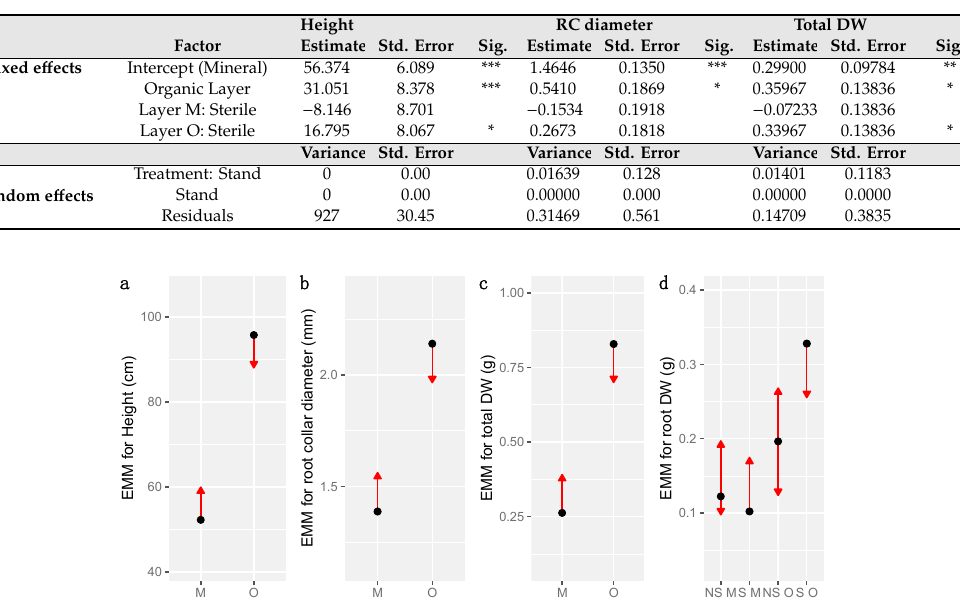
Figure 4. Comparison of estimated marginal means (EMM) showing significant differences of height ( a ), root collar diameter ( b ), total dry weight ( c , DW), and root DW ( d ) of seedlings per soil layer (Mineral: M, Organic: O) and sterilization treatment (S: sterile, NS: non sterile). Blue bars indicate confidence intervals of estimated marginal means, arrows refer to comparisons among marginal means. If two arrows overlap, Tukey post-hoc tests are non-significant and p -value for pairwise comparisons are > 0.05. Table 2. LMM estimates for height, root collar (RC) diameter, total dry weight (DW). Std: standard error, p: p -value. *: p -value < 0.01, **: p -value < 0.001, ***: p -value < 0.0001. LMM formula: ~Layer + Layer/Steril + (1|Stand/Treatment).